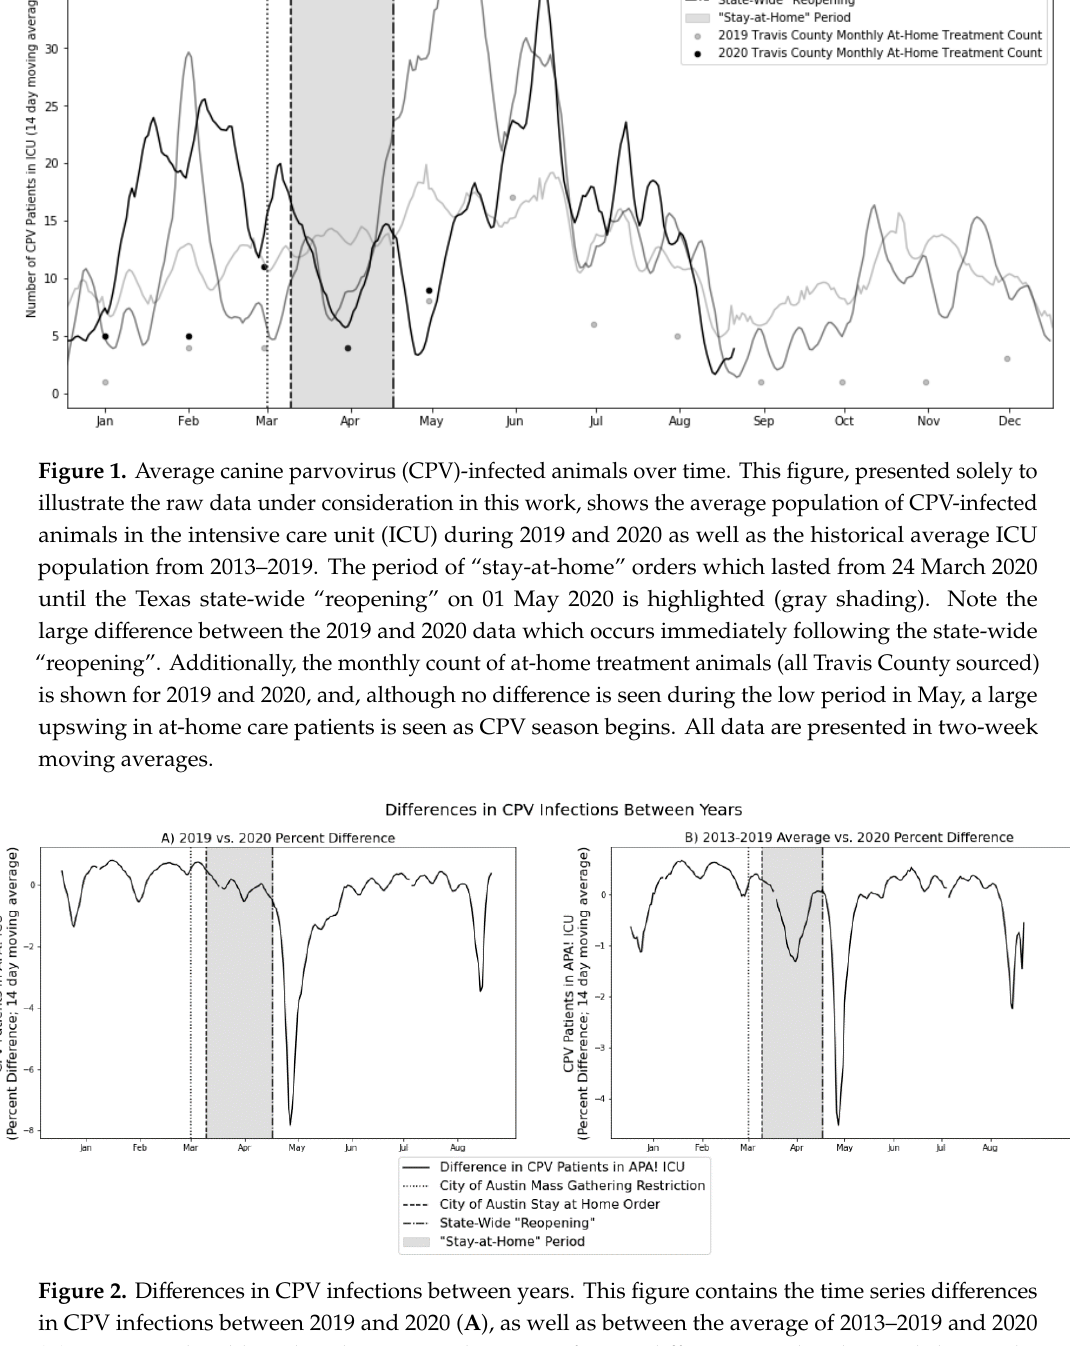
Figure 2. Differences in CPV infections between years. This figure contains the time series differences in CPV infections between 2019 and 2020 ( A ), as well as between the average of 2013–2019 and 2020 ( B ). Importantly, although a decrease in the CPV infection di ff erence can be observed during the pandemic-related “stay-at-home” order (gray shading) when compared to the historical trend ( B ), this same decrease was indeed present in 2019 ( A ; also see Figure 1). Therefore, this decrease is unlikely to be related to changes in human behavior due to the “stay-at-home” order. The larger decrease, however, immediately after the “reopening” event, is not seen in any previous years. The associated date of maximum di ff erence was 11 May 2020, 11 days after the state-wide “reopening”. All data are presented in two-week moving